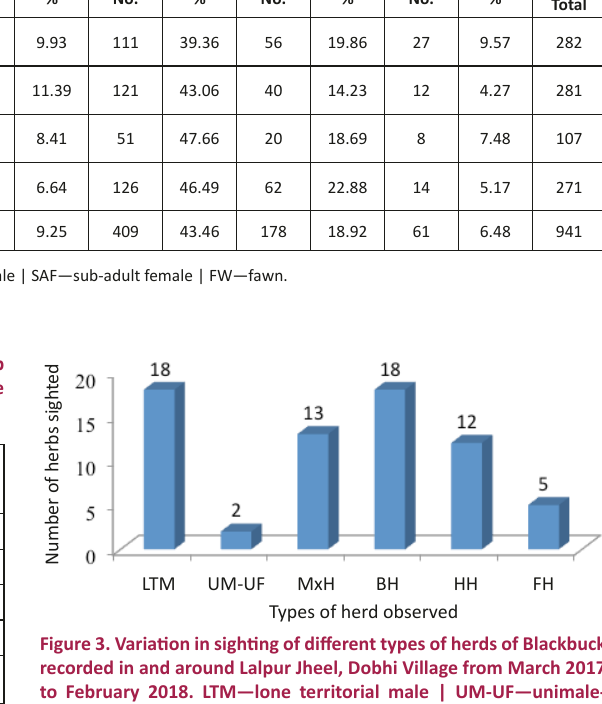
Table 3. Age structure of Blackbuck in Lalpur Jheel, Dobhi Village of district Hisar, Haryana (India) from March 2017 to February 2018. AM TotalNo. % Season(s)